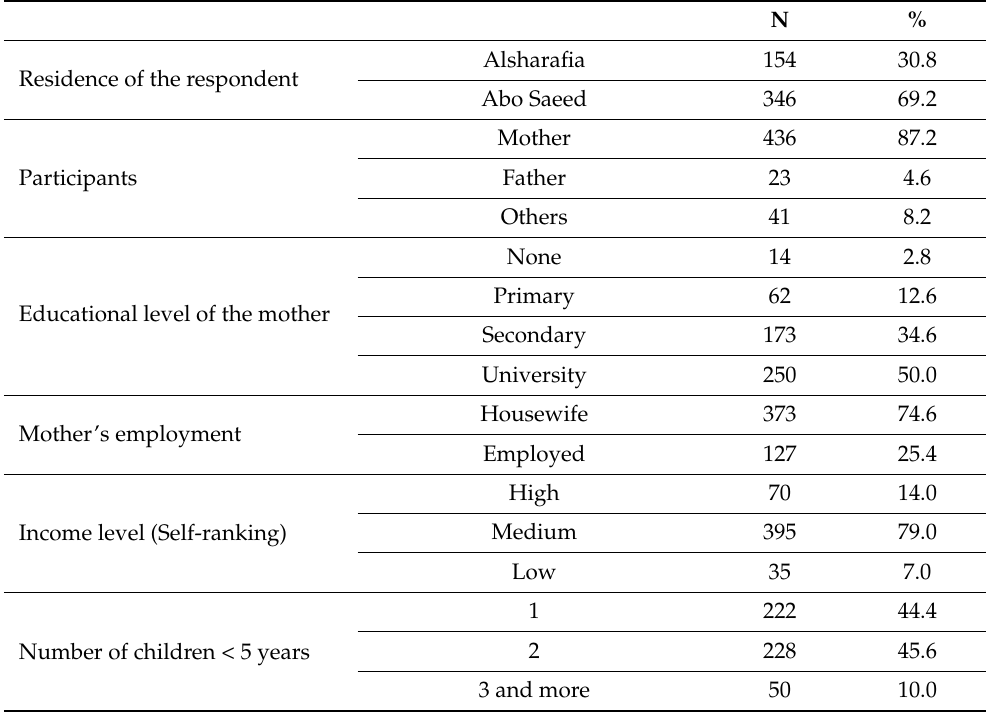
Table 1. Sociodemographic characteristics of the respondents and their status of exposure to vaccina- tion